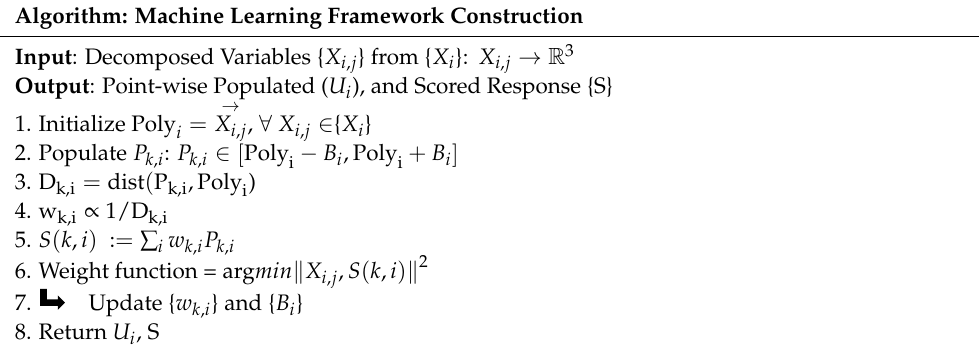
Algorithm: Machine Learning Framework Construction